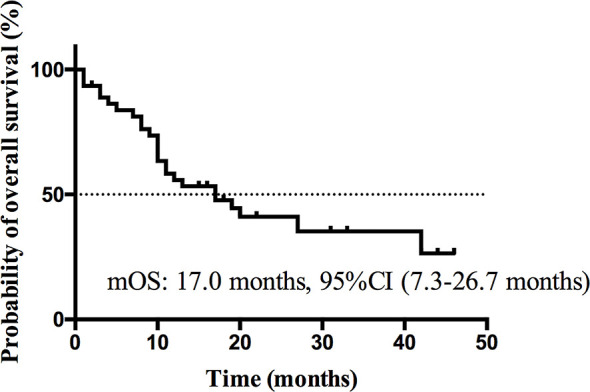
Kaplan-Meier curve of OS of all patients.